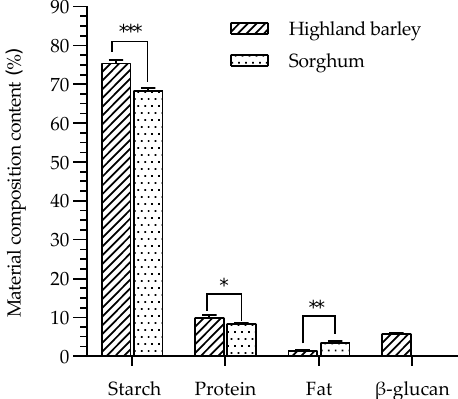
Figure 2. Contents of main substances in highland barley and sorghum; * p < 0.05; ** p < 0.01; and *** p < 0.001.